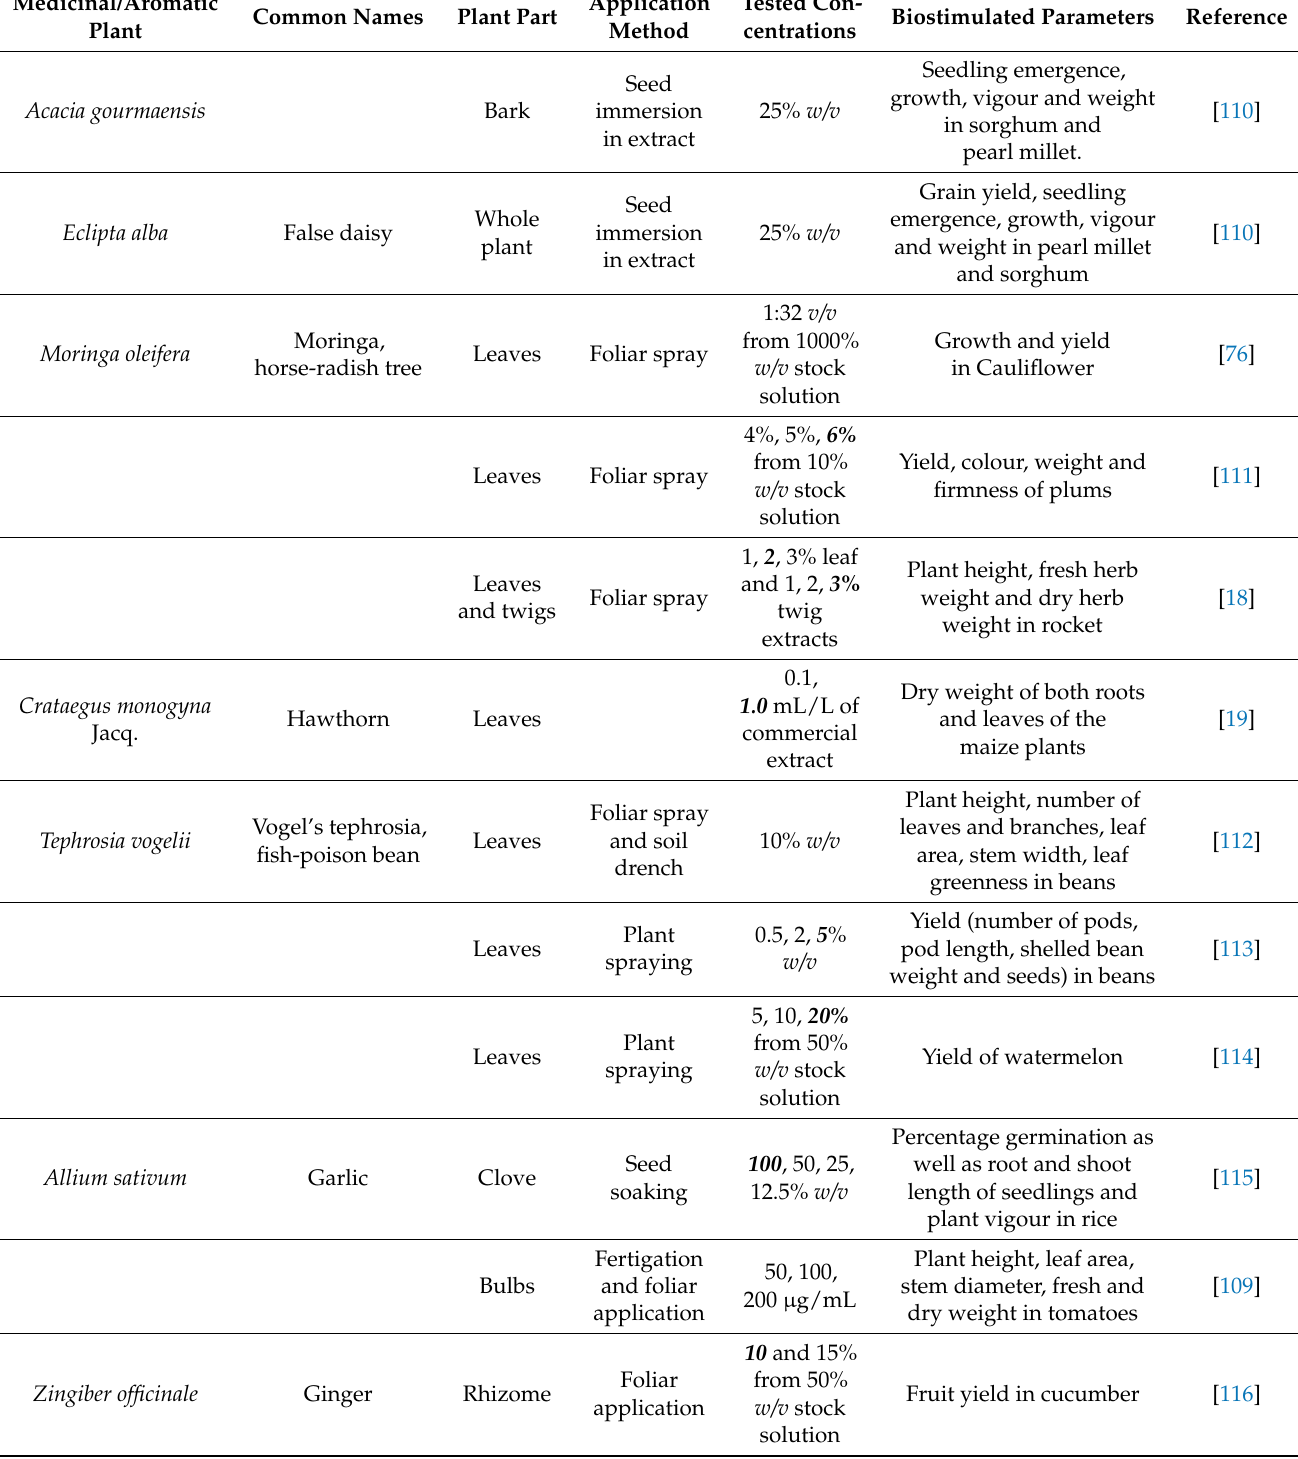
Table 3. Selected medicinal and aromatic plant extracts with biostimulant